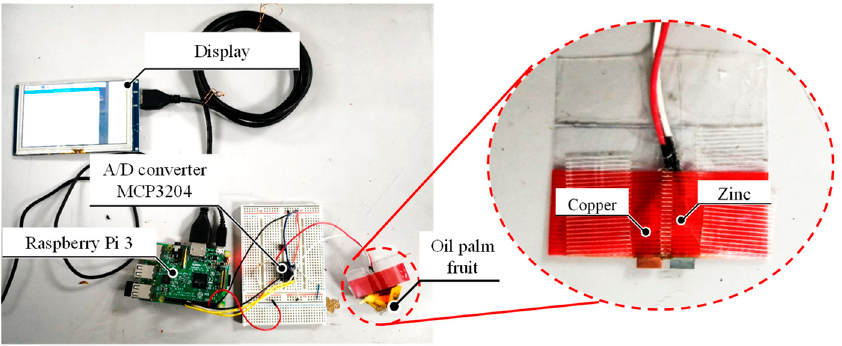
Figure 8. The prototype device that estimates oil palm fruit’s moisture content using Raspberry Pi 3 Model B. Model